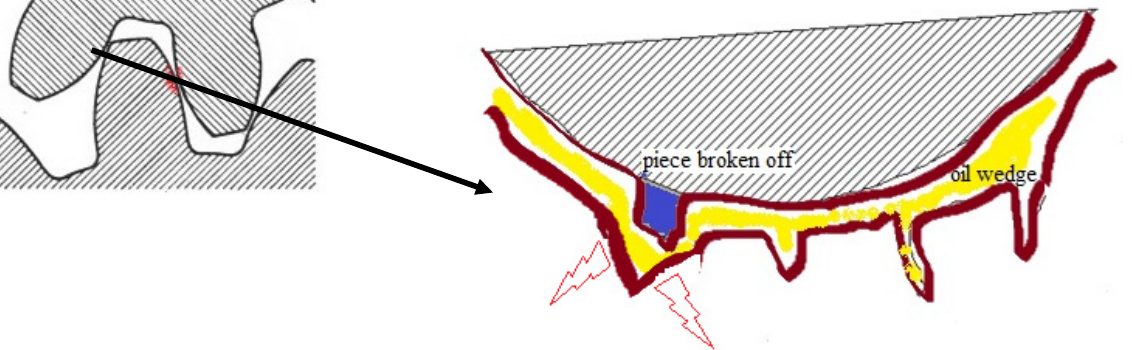
Figure 7. Process of pitting wear in the gear wheel.